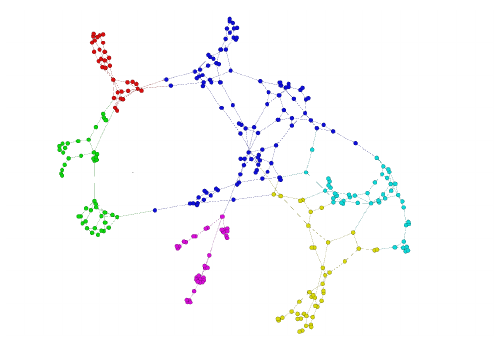
Fig. 12 Partitioning power grid